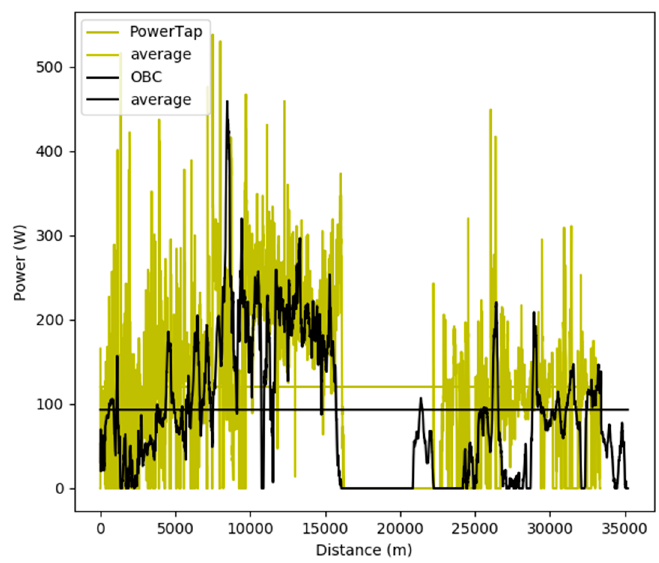
Figure 13 . Power vector comparison and average power comparison. Figure 13. Power vector comparison and average power comparison.